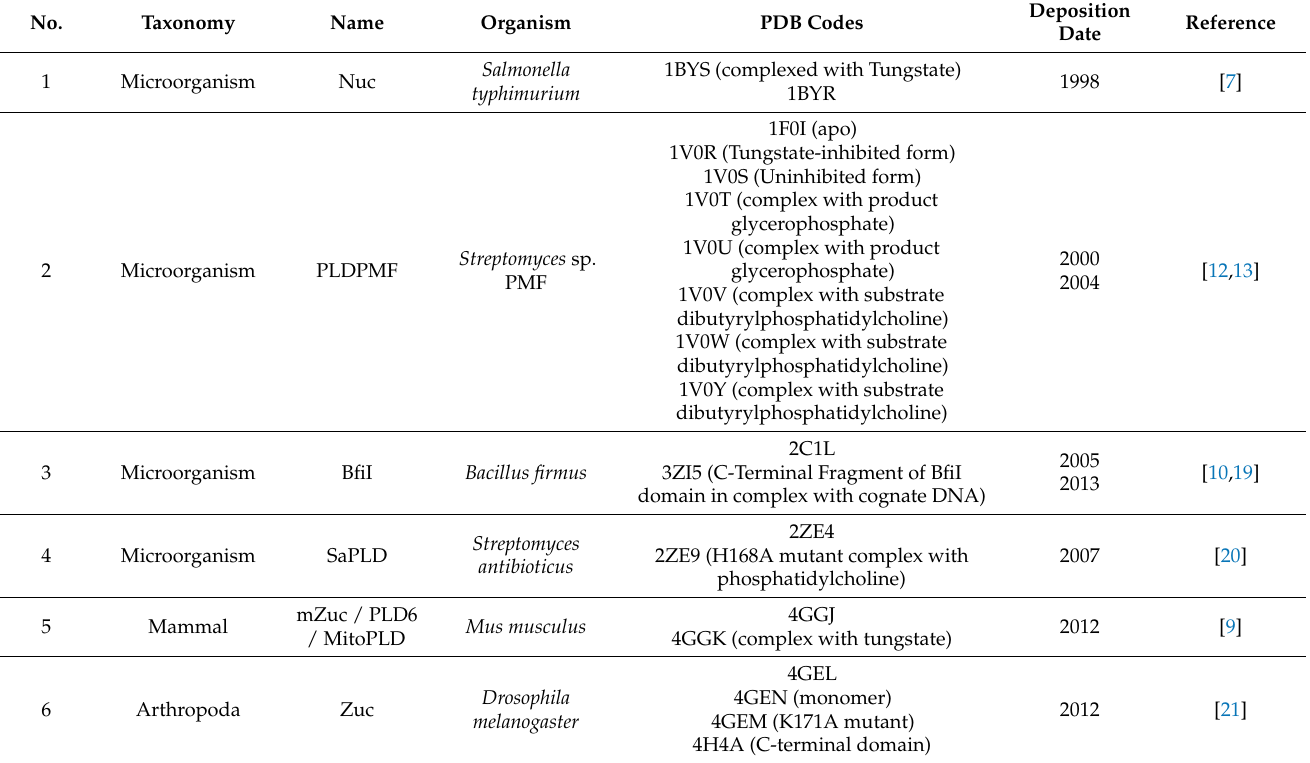
Table 1. Structural information of resolved phospholipases D (PLDs) in the PLDc 2 (PF13091) family.